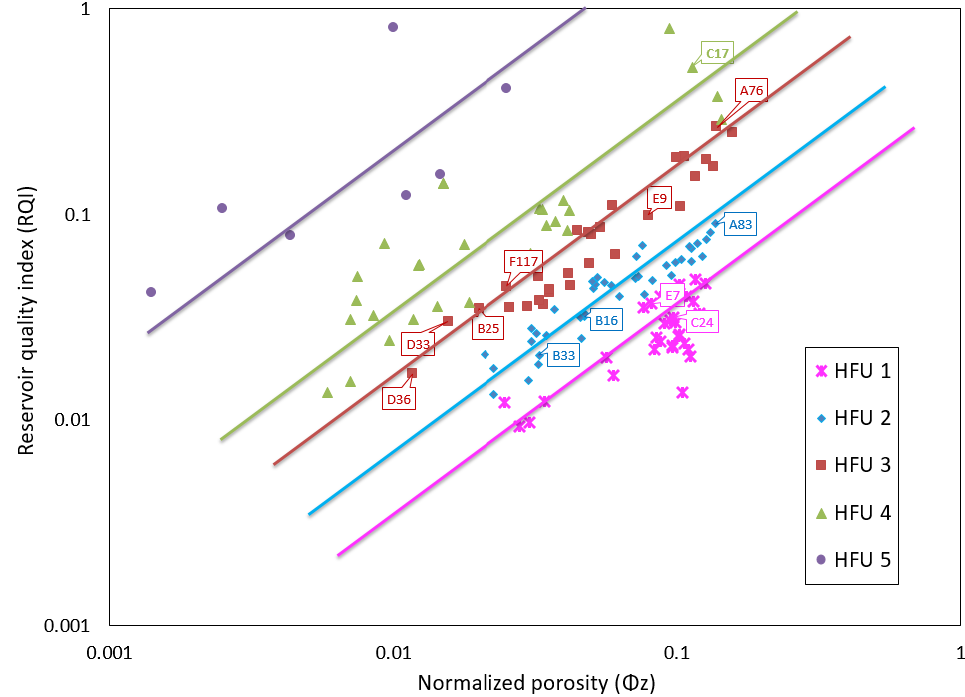
Figure 8. Hydraulic flow units of the reservoir identified from 140 rock samples from six wells.